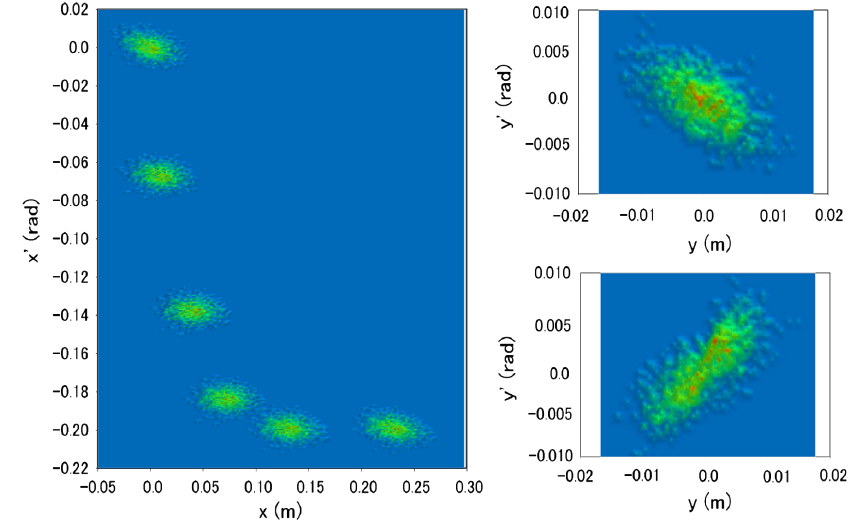
voltage).FIG. 19. Phase space distribution in the kicker field. In the left figure, the phase plot moves from the lower right to the upper left along the beam passage. The origin corresponds to the end of the injection kicker. Two right-hand figures show the beam distributions in the vertical phase space: the upper figure is for the beam at the entrance and the lower is at the exit of the kicker. The central orbit in the DA ring is x ¼ 0 : 0 and y ¼ 0 : 0 in each